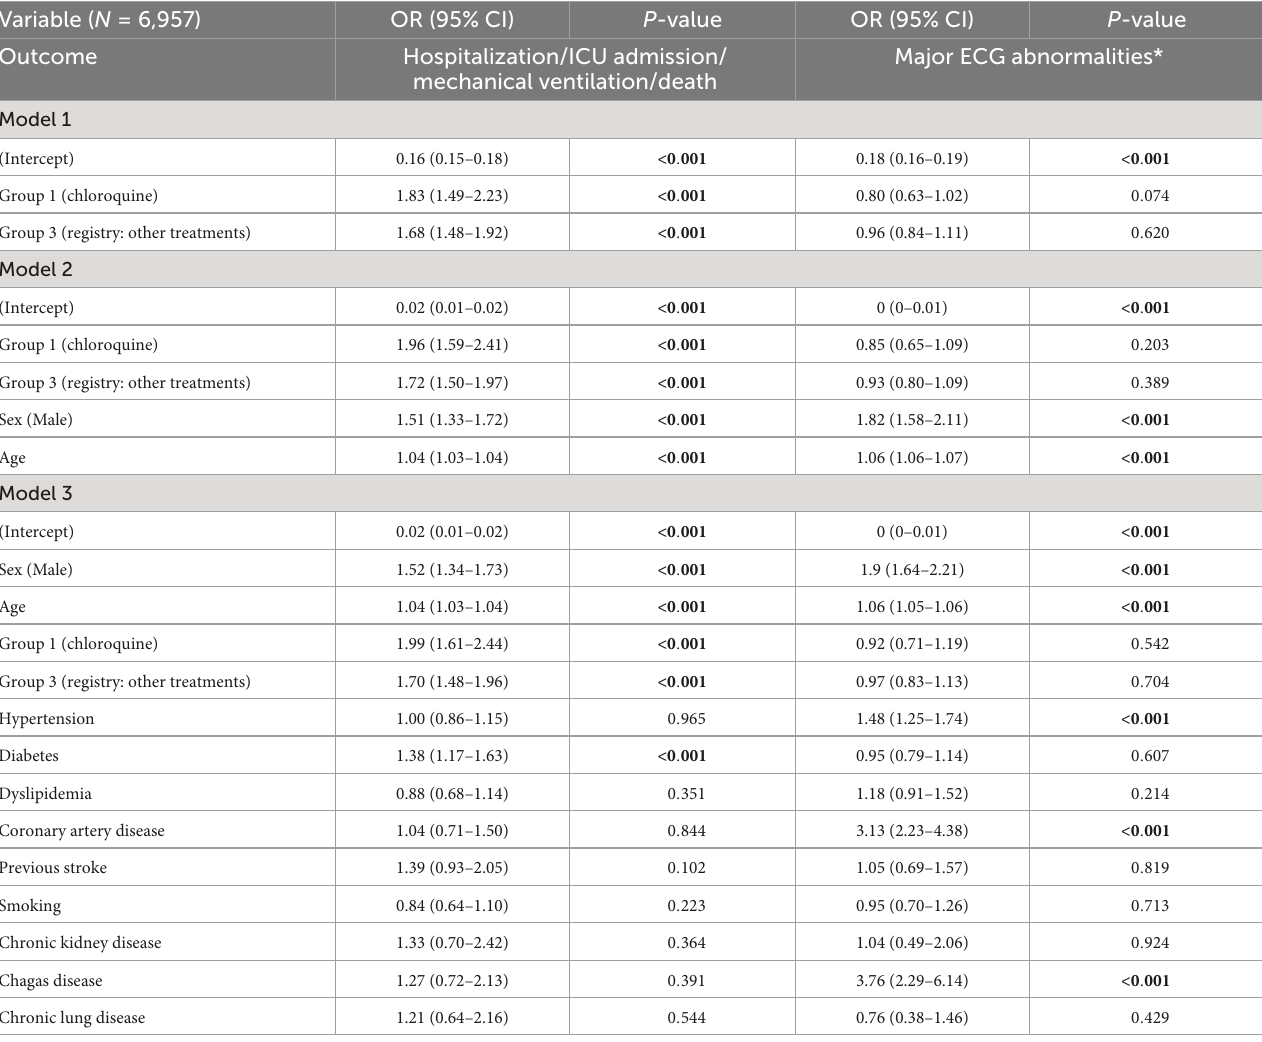
TABLE 4 Multivariate risk model for the composite primary outcome (hospitalization/ICU/mechanical ventilation/death) assessed by phone follow-up plus administrative databases, and for the primary electrocardiographic outcome (major ECG abnormalities by the Minnesota code), adjusted for demographic and clinical